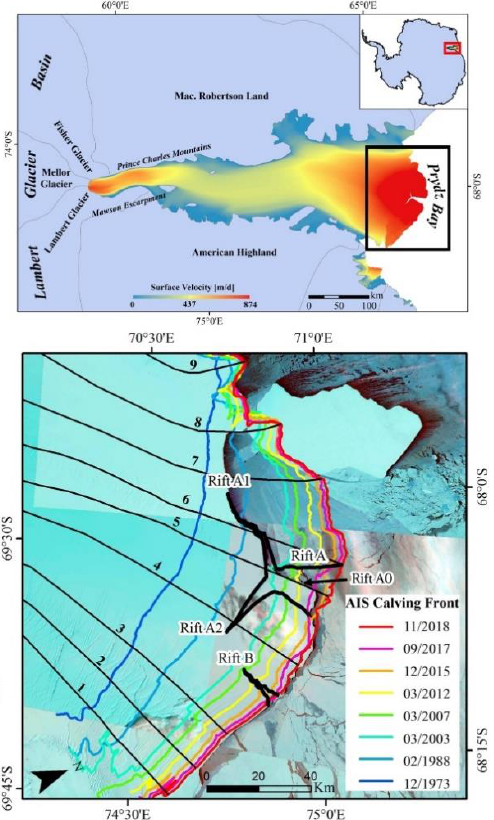
Figure 1. ( Top ) Geographic location of the AIS in East Antarctica. ( Bottom ) Geographic location of the rift system and the CFLs derived from this study. Nine flowlines were shown in black and labeled from east to west as 1 – 9. Eight CFLs on the AIS were delineated for the period of 1973 – 2019. The four rifts A0, A1, A2, and B in bold black line were delineated manually using two Landsat 8 images acquired in November 2018. The background Landsat 8 images acquired in October 2019, illustrate the changes in CFL as well as the iceberg D-28 which broke off and drifted northwards.